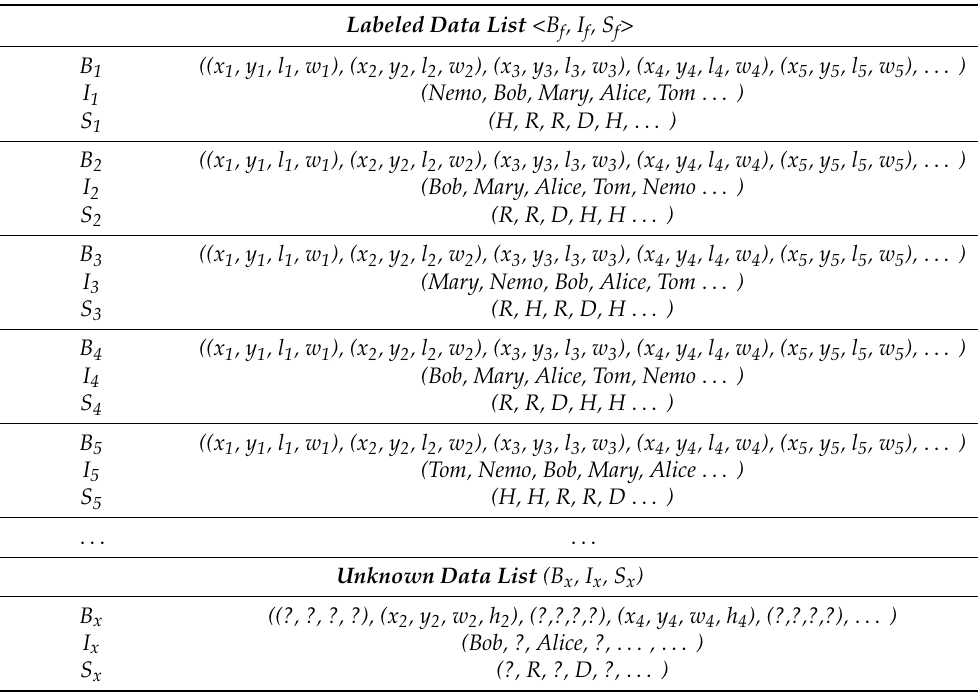
Table 1. An example of a labeled and unknown data